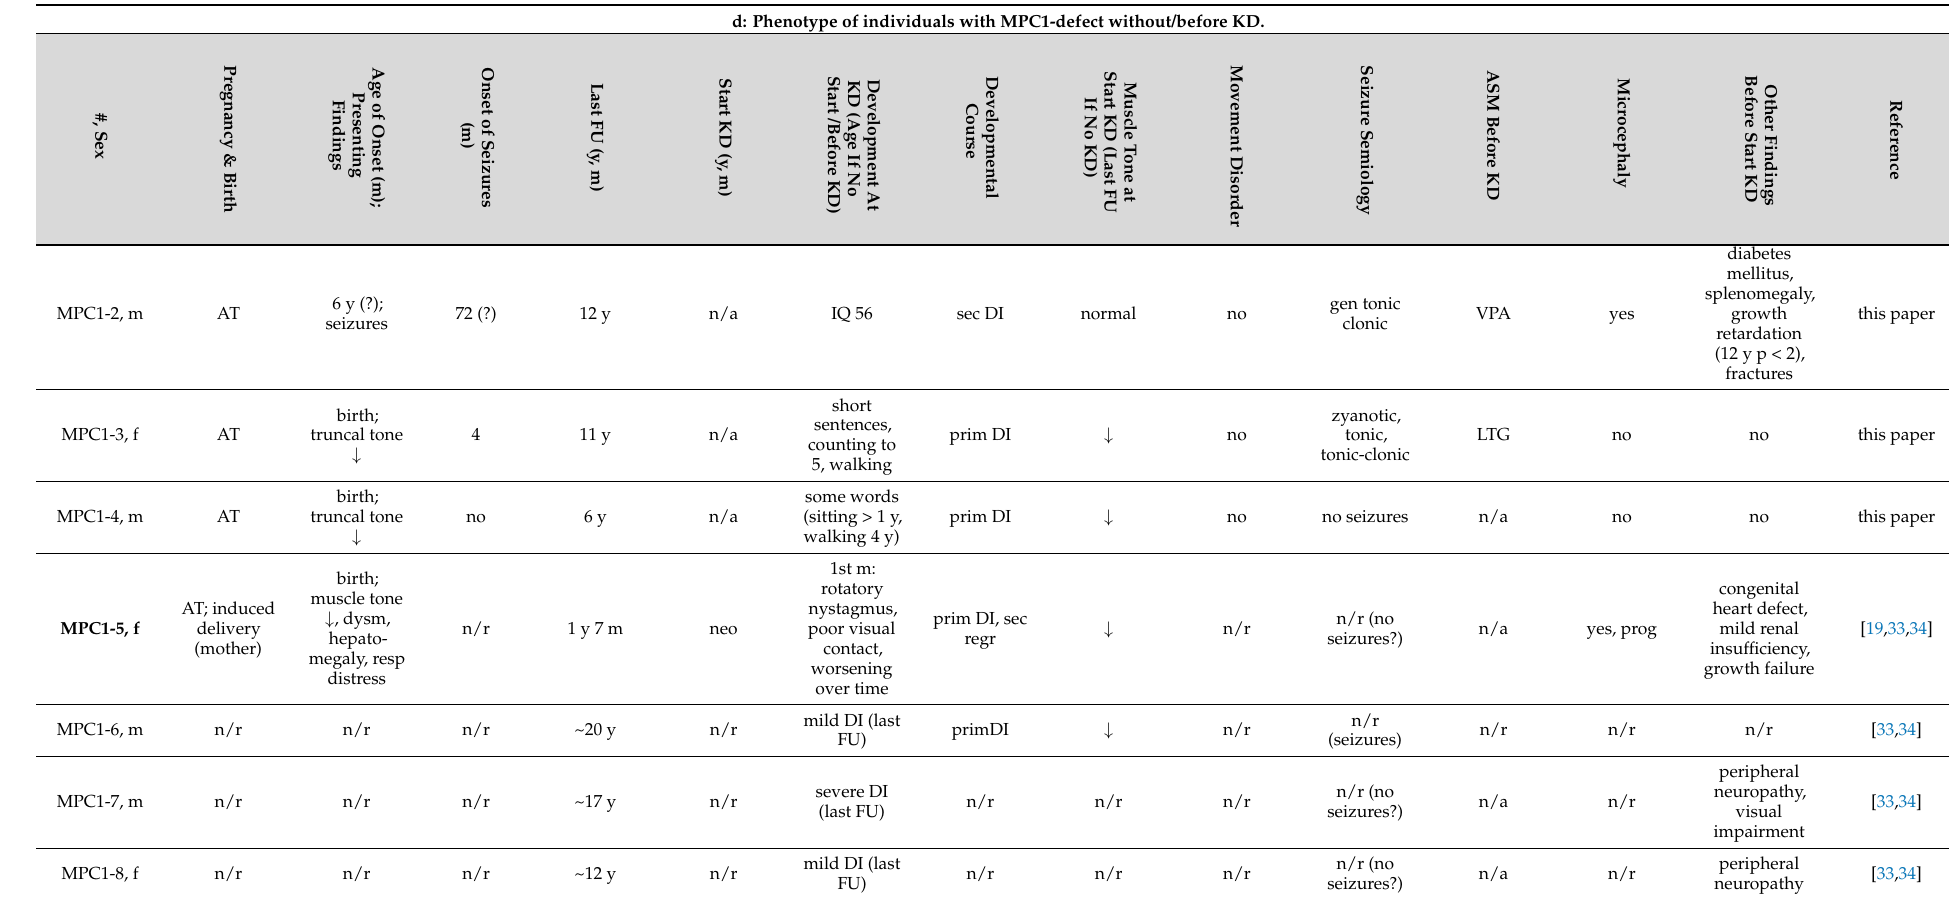
d: Phenotype of individuals with MPC1-defect without/before